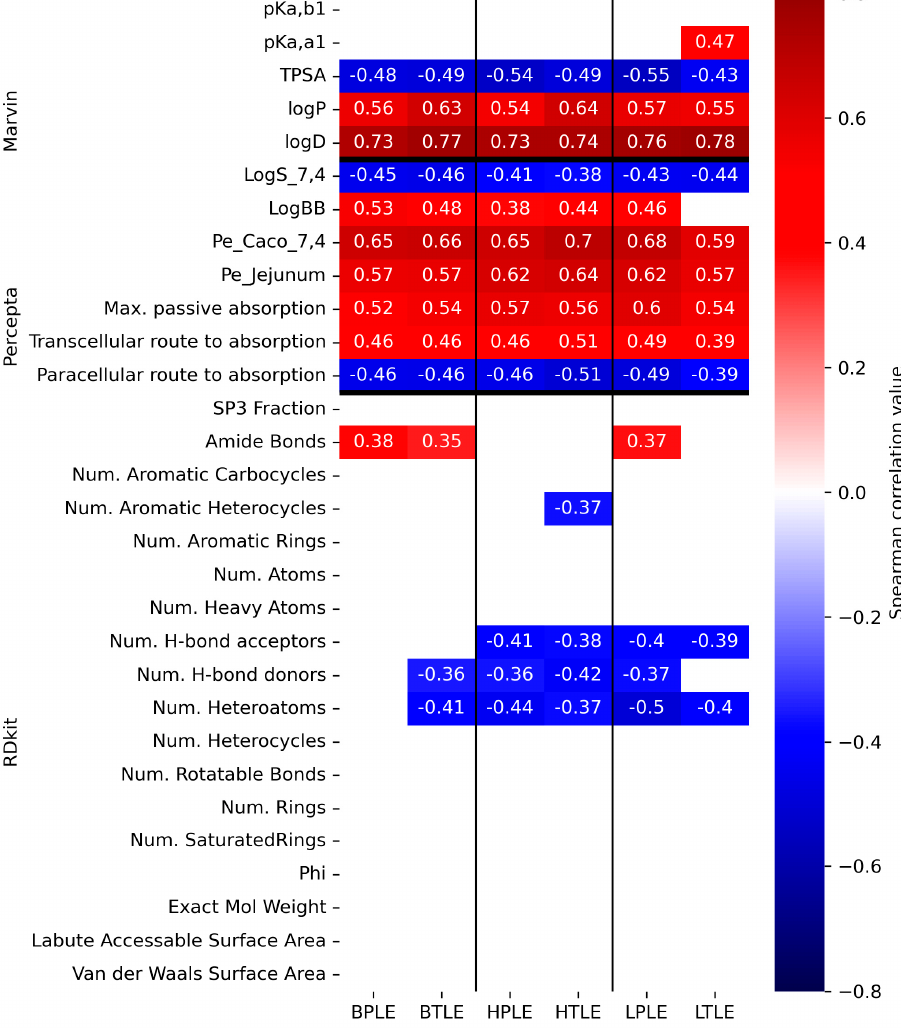
Figure 13. Spearman correlation matrix between the permeability values (n = 3) and the selected descriptors. Only the most significant correlation values are shown (with a significance level of p < 0.05). Predicted descriptors and permeability data can be found in Tables S1 and S2 in the Supplementary material respectively.